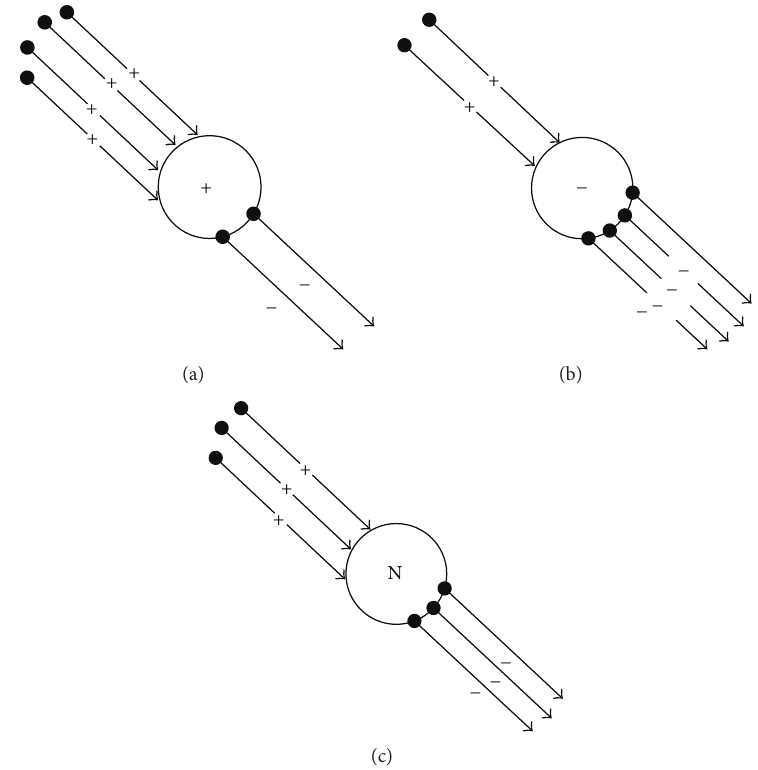
Figure 4: Three kinds of microblogging